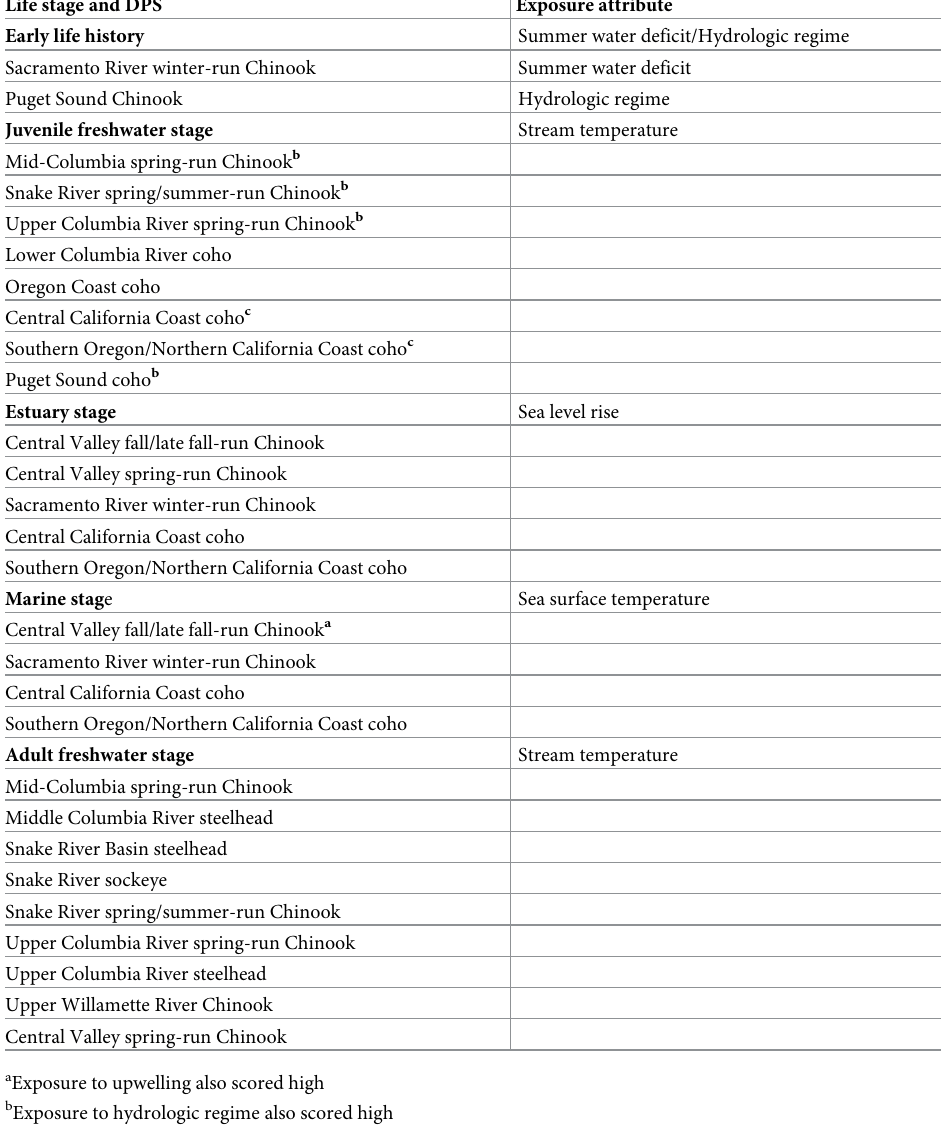
Table 5. Highly vulnerable life stages by DPS with associated exposure attributes. Criterion for inclusion was a score of 3 or higher in both sensitivity and exposure attributes in each subheading. Additional high exposure scores for upwelling (a), flow regime (b), and flooding (c) also occurred in some